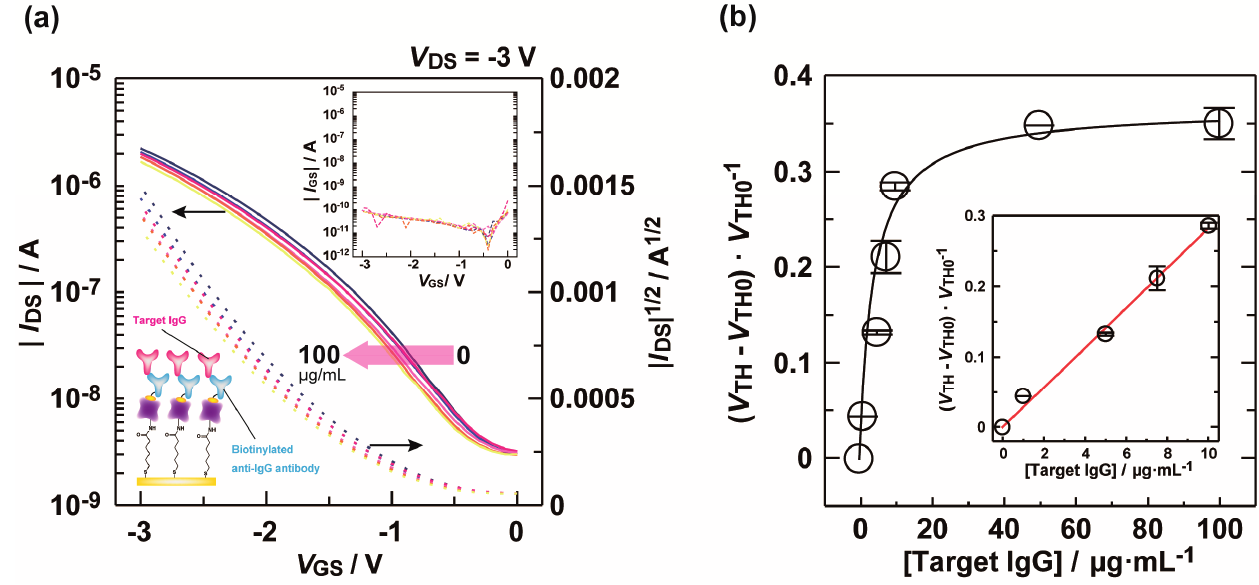
Figure 4. ( a ) Transfer characteristics ( I –V ) of the OFET upon titration with target IgG DS GS in a D-PBS solution with 0.1 wt% BSA. [Target IgG] = 0–100 μ g/mL. The inset shows the gate-source current ( I –V ); ( b ) Changes in threshold voltage ( V ) for the OFET by GS GS TH target IgG at various concentrations in a D-PBS solution with 0.1 wt% BSA. The inset shows the lower end of the